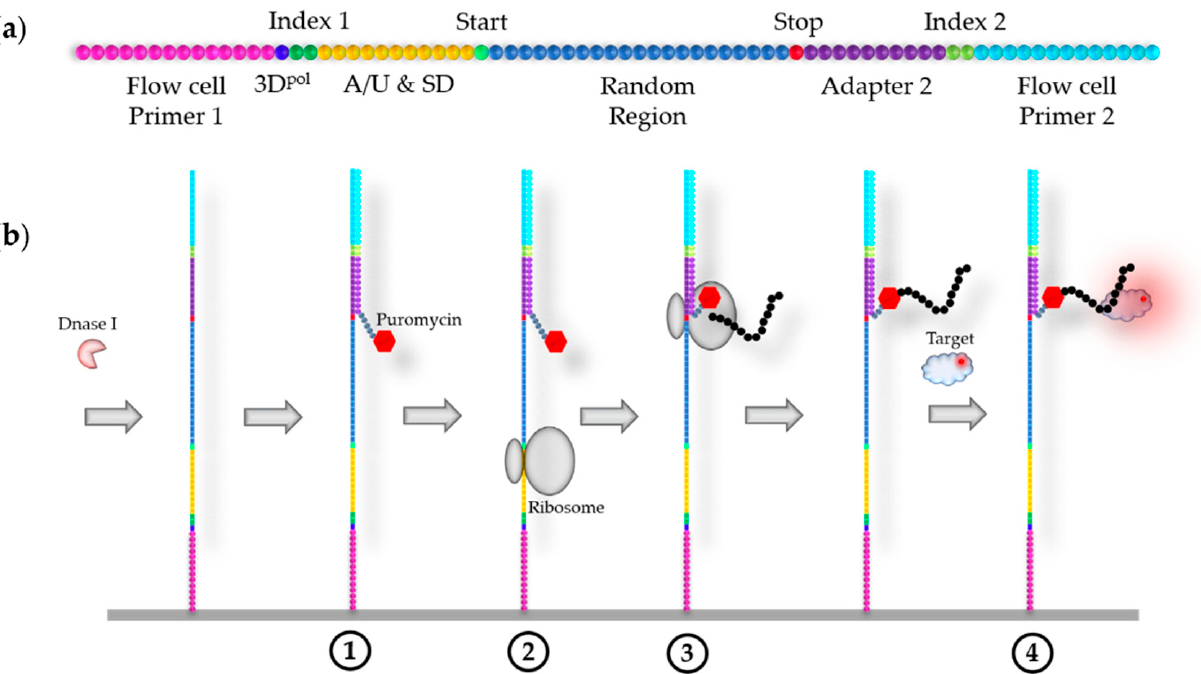
Figure 6. Illustration of peptide display HiTS–FLIP, according to Svensen et al. [33]. ( a ) The initial DNA library designed for paired-end sequencing, followed by in situ transcription and translation; 3D pol : initiation site for poliovirus RNAP; A/U: A/U-rich translation initiation enhancer; SD: Shine–Dalgarno sequence; Start: start codon; Stop: stop codon. ( b ) The peptide display HiTS–FLIP process starting with the RNA clusters, generated as depicted in Figure 5b.